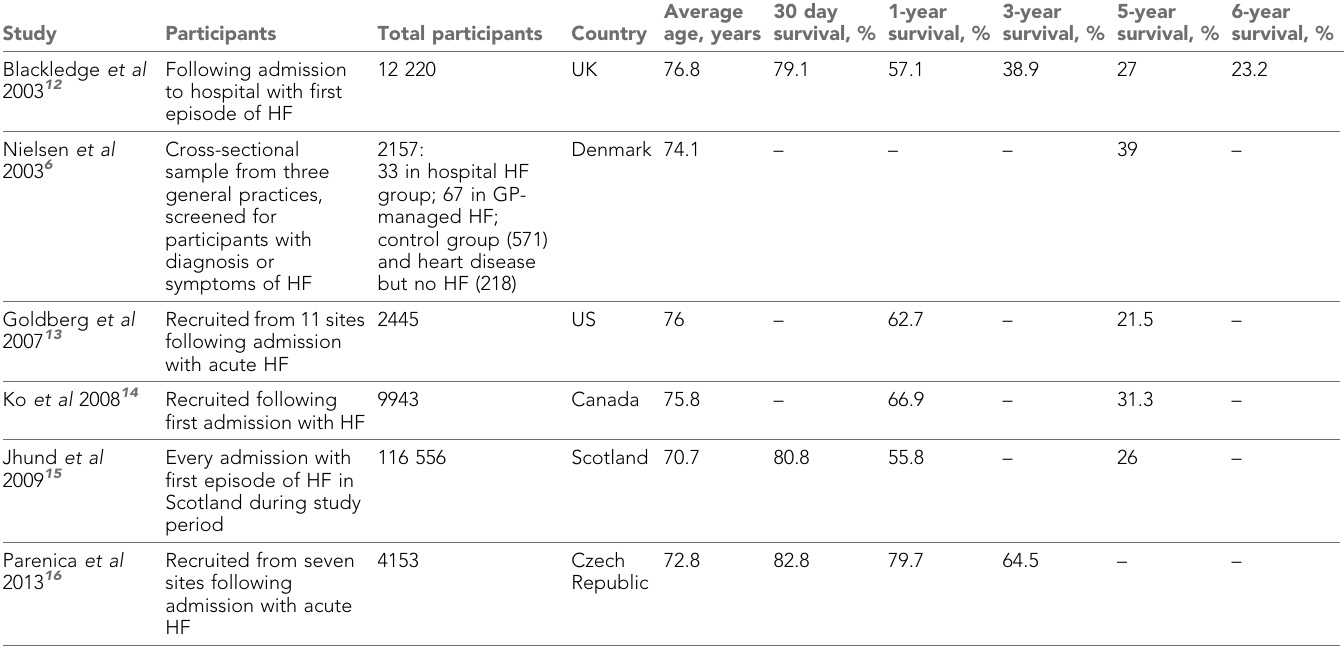
Table 2. Survival rates in acute heart failure Study Participants